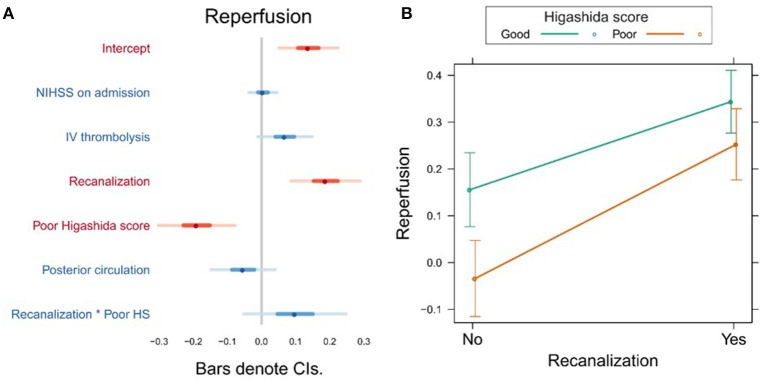
(A) Association between several variables and reperfusion. The dots indicate the beta coefficients derived from a robust multiple linear regression. Bars indicate the 95% confidence intervals (CI) of the estimates. Independent variables shown in red have statistically significant coefficients (p < 0.05). (B) Plot showing the predicted reperfusion values for recanalizers and non-recanalizers with good and poor Higashida scores. The plot shows that vessel recanalization and good collateral flow are associated with more reperfusion. The association between recanalization and reperfusion is similar across patients, whether or not they have good collateral flow.